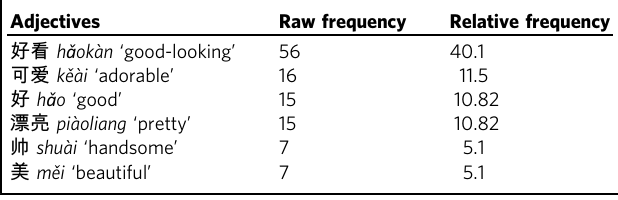
Table 3 Top 10 words in boys ’ normal speech style. Word types